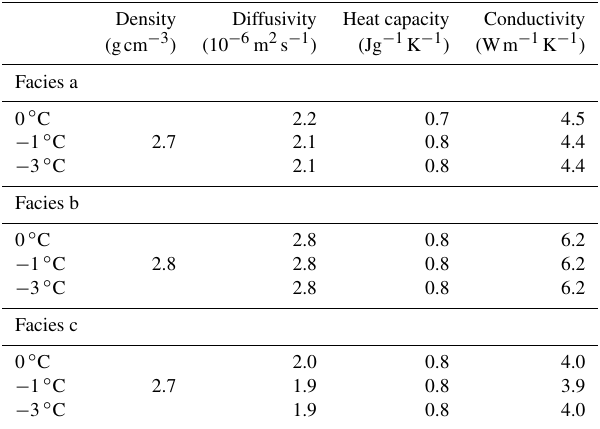
Table 2. Thermal properties of the three different facies occurring in SSB measured in the laboratory at three different steps of tem- perature (0; − 1 and − 2 ◦